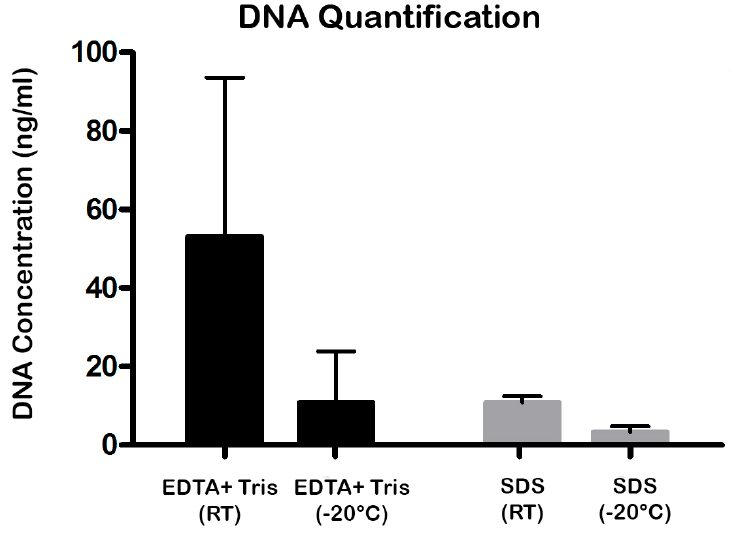
Figure 3. Analysis of the dsDNA content on skeletal muscles’